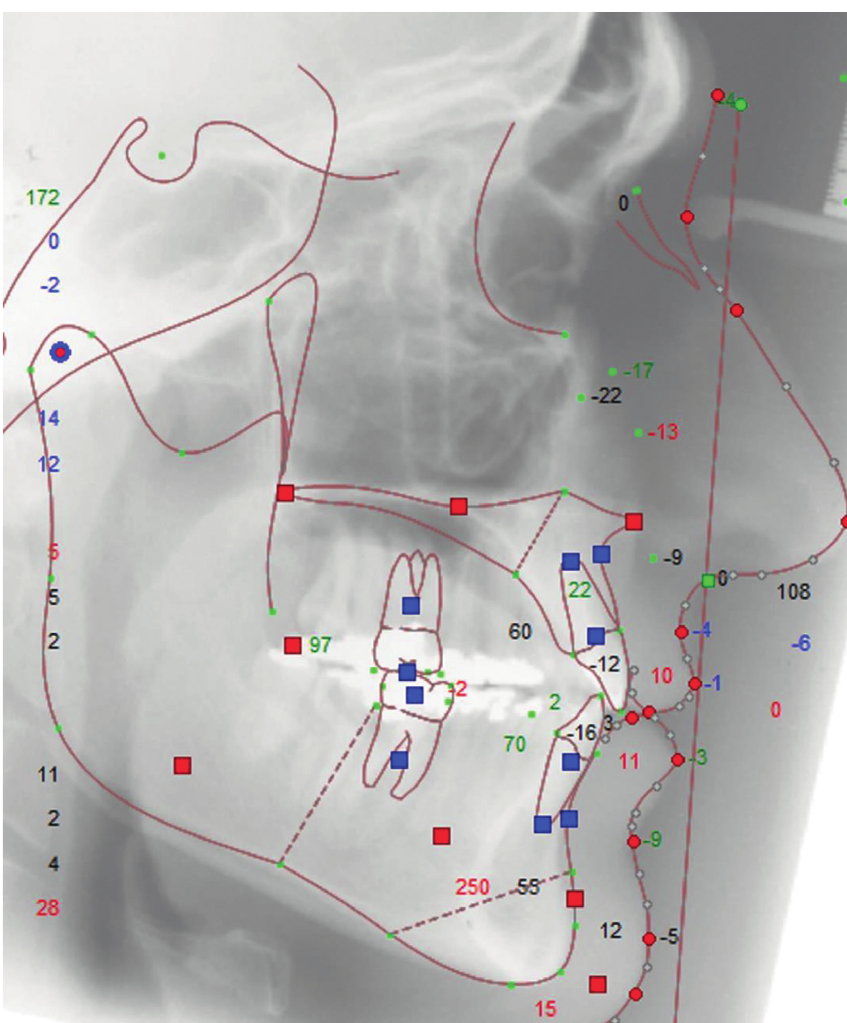
Figure 2: Final cephalometric